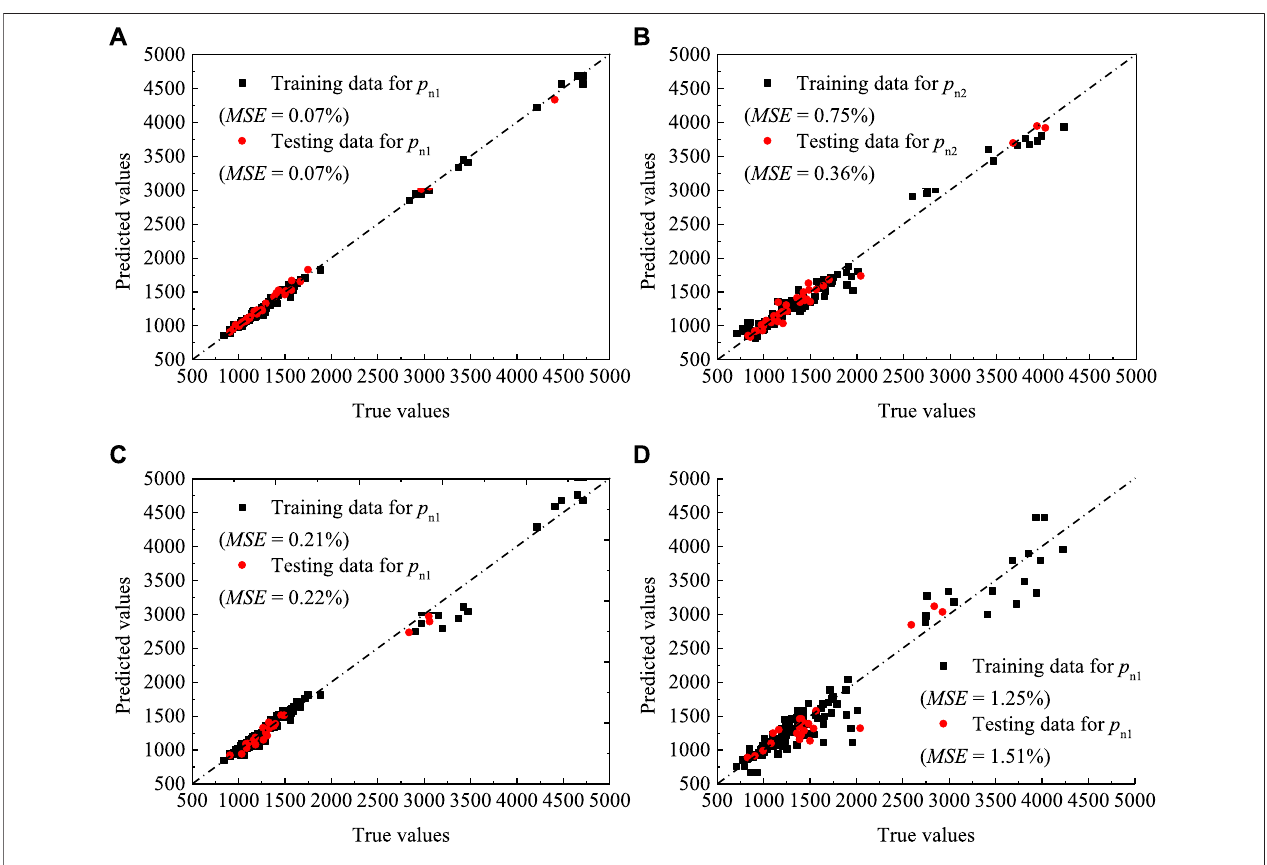
FIGURE 16 | Proposed neural network model via the test results: (A,B) Using the “ nnet ” algorithm; (C,D) Using the “ Trainlm ” algorithm.